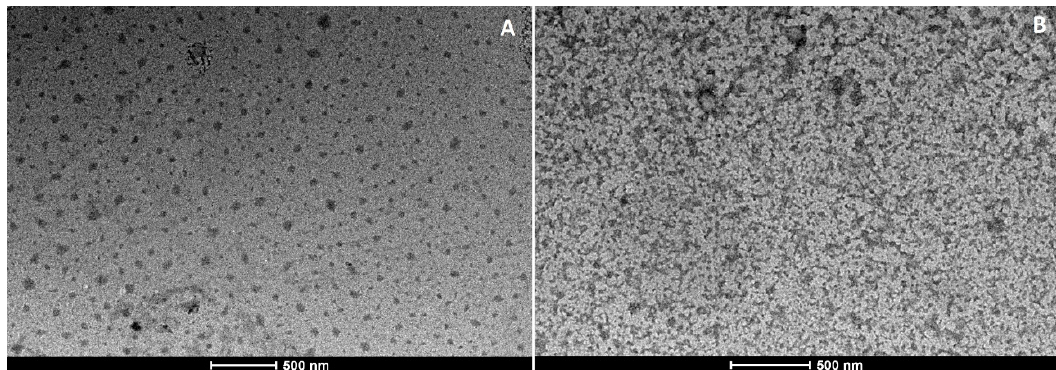
Figure 2. TEM images of SLN-W ( A ) and SLN-Wb ( B ).